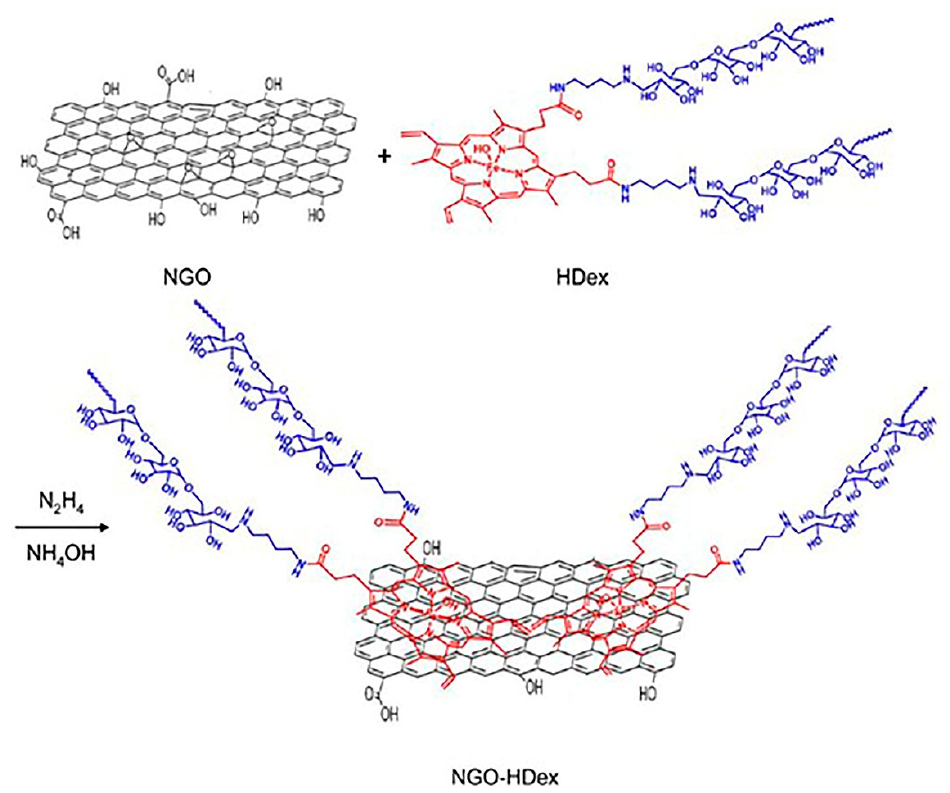
Figure 10. Synthesis of nanographene oxide (NGO) − dextran–hematin (HDex) hybrids [169]. (Reprinted with permission from Jin et al. ‘Self ‐ assembled graphene ‐ dextran nanohybrid for killing drug ‐ resistant cancer cells’. ACS Applied Materials & Interfaces 2013, 5 (15), 7181–9. Copyright (2020) American Chemical Society).